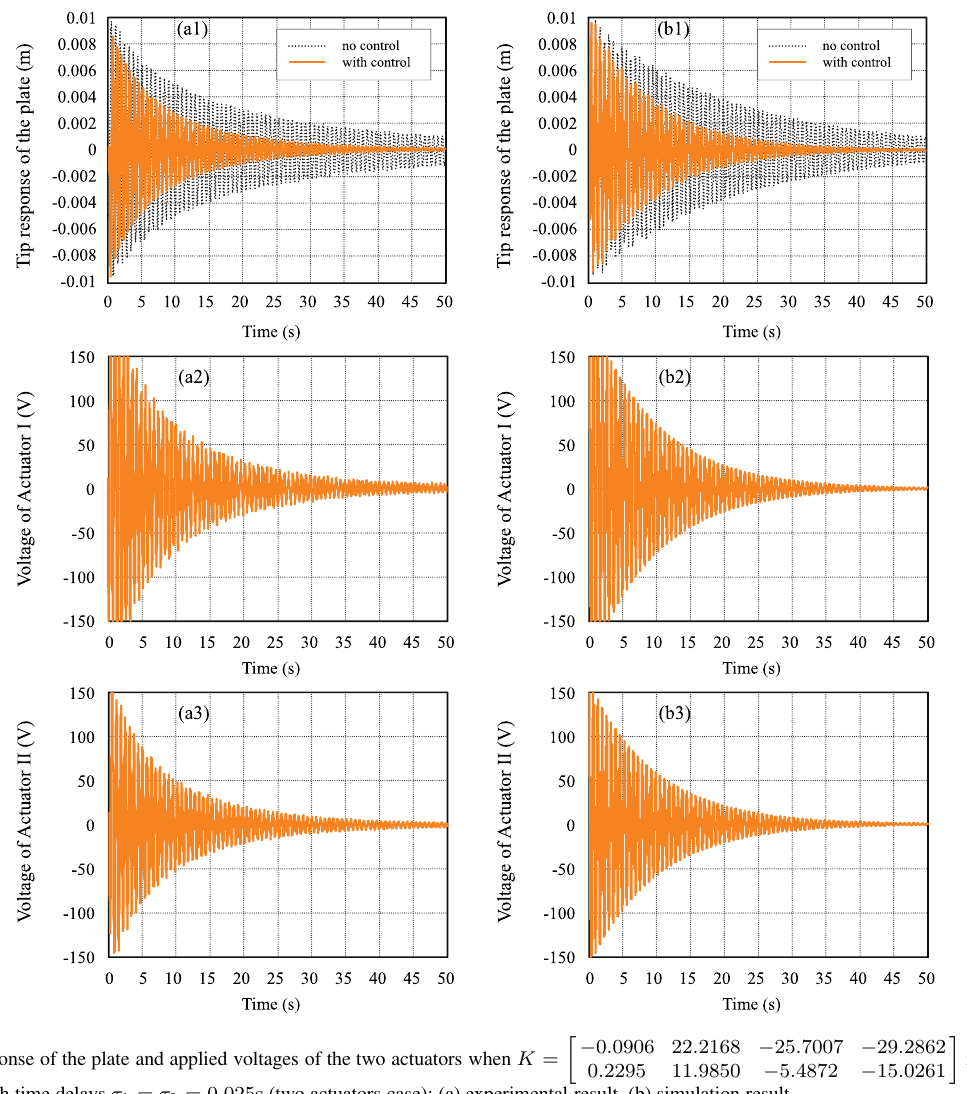
Fig. 7. Response of the plate and applied voltages of the two actuators when K = the plate with time delays τ 1 = τ 2 = 0 . 025s (two actuators case): (a) experimental result, (b) simulation